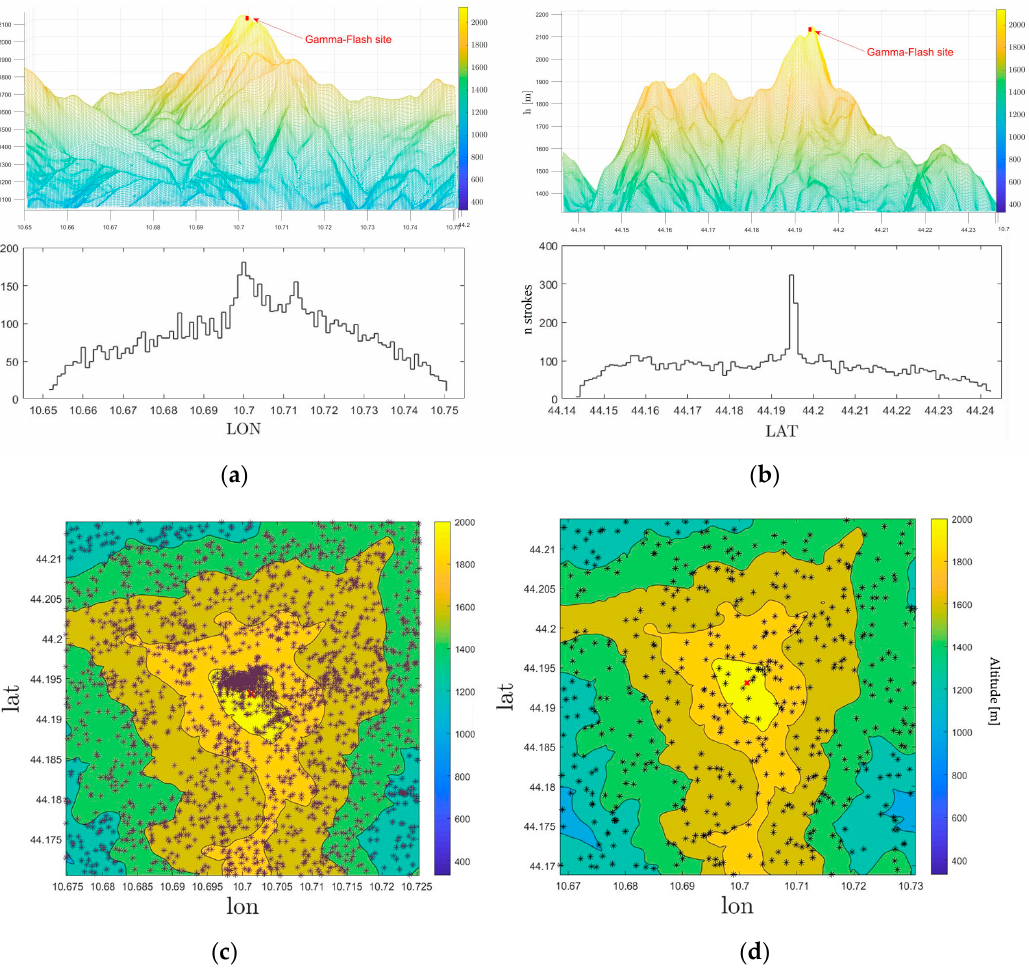
Figure 3. LINET lightning location maps over the Mt. Cimone area: ( a , b ) total lightning activity along the orography in two cutting directions centered on the GF site; ( c ) located CG flash detections; ( d ) located IC flash detections. Area: 5 km around the observatory. Ref. period: 2012–2020. The red placeholder indicates the position of the GF site.